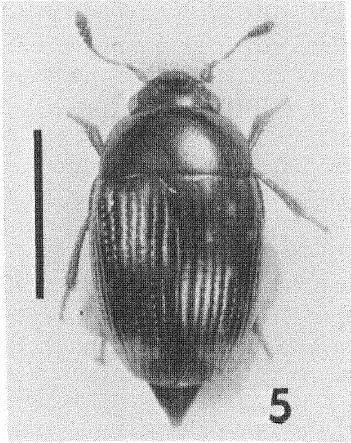
Fig. 5. Glypholoma rotundulum. Scale